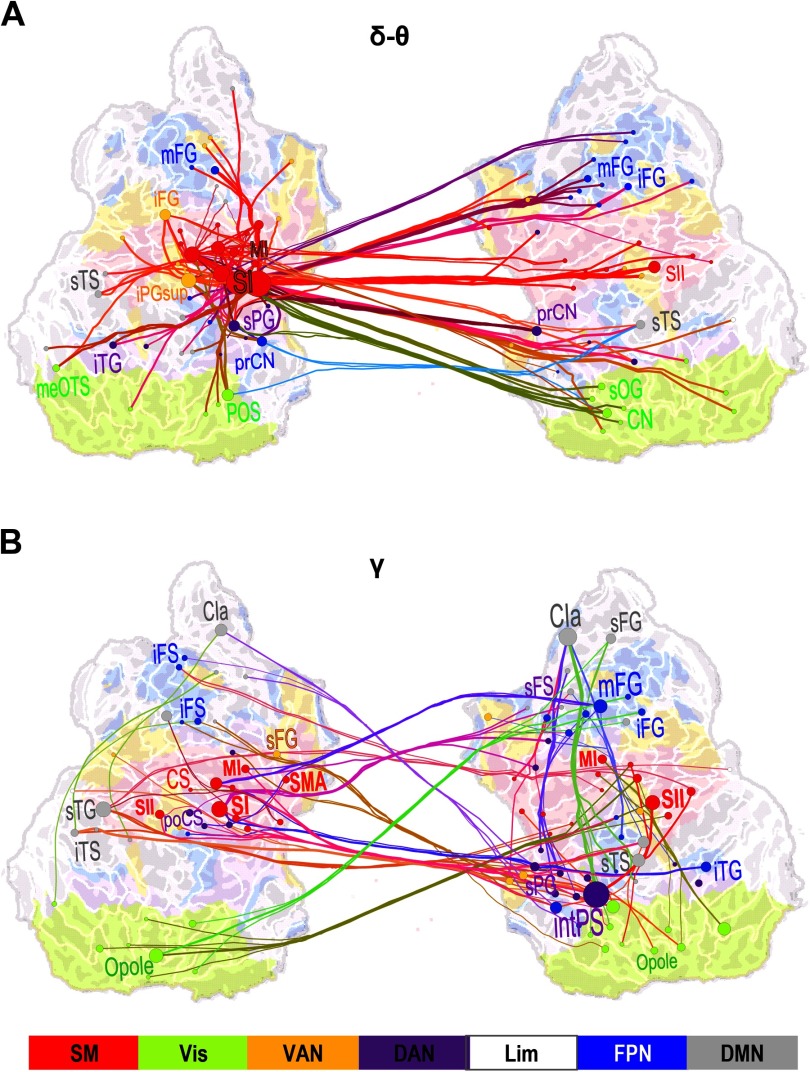
Large-scale synchronization connects somatosensory and attentional brain systems. (A) Graph of the significant differences in the strength of interareal phase synchrony as estimated with PLV between Hits and Misses in the delta/theta-frequency band (δ/θ, 3–7 Hz) and in the time window of 125–275 ms from stimulus onset (cf. Figure 2C). Lines connect the coupled parcels and line colors are determined by the parcel brain systems (see below). Delta/theta-band synchronization was centered on the contralateral (left hemispheric) sensorimotor (SM, red) system, and in particular, on the primary somatosensory cortex (SI) therein that was strongly and bilaterally coupled with frontal and parietal regions. (B) Graph of gamma-band synchronization (γ, 40–60 Hz) reveal significantly stronger connections for Hits than Misses over 225–375 ms from stimulus onset. Stronger gamma-band synchronization for Hits than Misses was observed within SM and between SM and the ipsilateral frontoparietal and dorsal (FP and DA, blue and purple) attention networks. Graphs are displayed on an inflated and flattened cortical surface with 300 (A) and 200 (B) of the most central edges based on parcel PageRank centralities selected for visualization. SI is primary and SII is secondary somatosensory area. MI and SMA are primary and supplementary motor areas, respectively. Parcel and corresponding node colors indicate the Yeo-atlas brain systems derived from BOLD intrinsic connectivity connectome. SM = somatomotor (SM), green = visual (Vis), yellow = ventral attention network (VAN), purple = dorsal attention network (DAN), white = limbic (Lim), gray = default mode network (DMN).